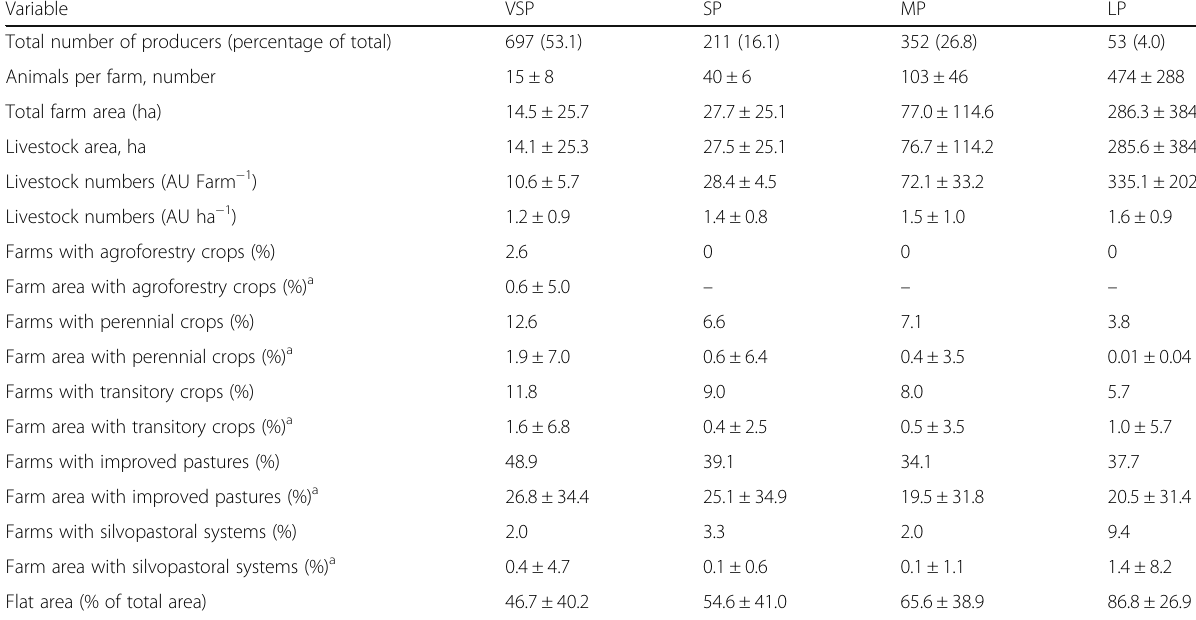
Table 2 Biophysical and land-use features in dual-purpose farms by category of livestock producers (average ± standard deviation) Variable VSP SP MP